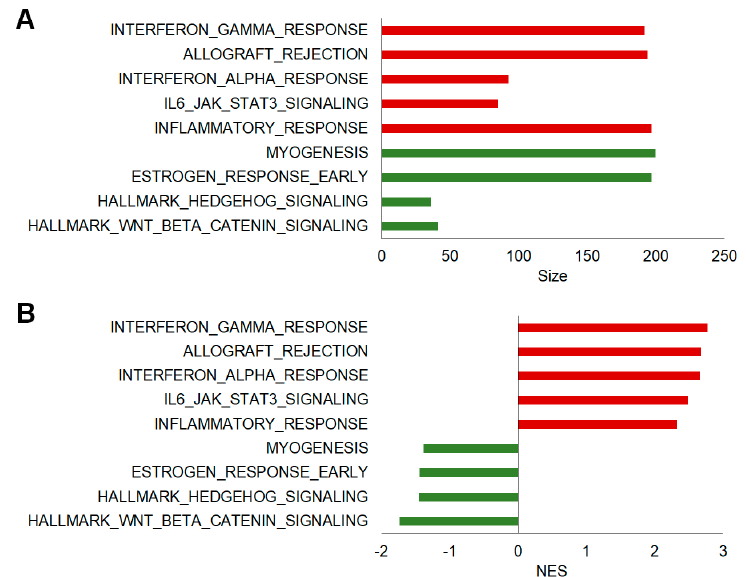
Figure 4. Hallmark gene sets enriched in the hippocampi of mice with EAE. The bar graphs show the top GSEA hallmark gene sets (FDR q -value < 0.25, NOM p -value < 0.05) that were enriched (positively (red) and negatively (green)) in EAE. The bars are ordered by the size of the gene set ( A ) and the normalized enrichment score (NES) indicates the strength of the enrichment ( B ). Table 2. Gene Set Enrichment Analysis (GSEA) results according to the MSigDB Hallmark gene sets.